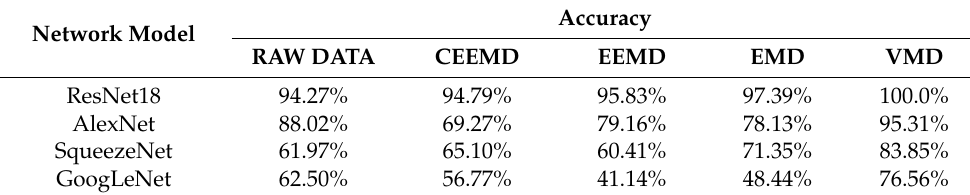
Table 10. The comparison of the fault diagnosis of the different network models. Network Model